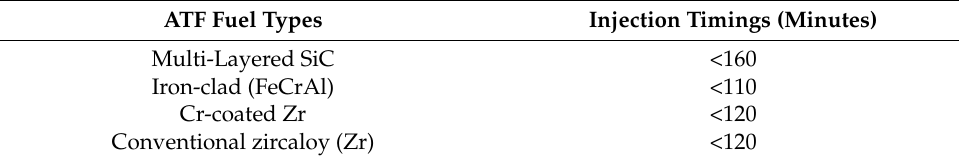
Figure 14. FLEX operational timing window for fuel candidates: ( a ) Multi-layered SiC; ( b ) Iron-clad (FeCrAl); ( c ) Chromium- coated Zircaloy (Cr-coated Zr); ( d ) Conventional Zircaloy (Zr). Table 8. FLEX operational timing window for each fuel